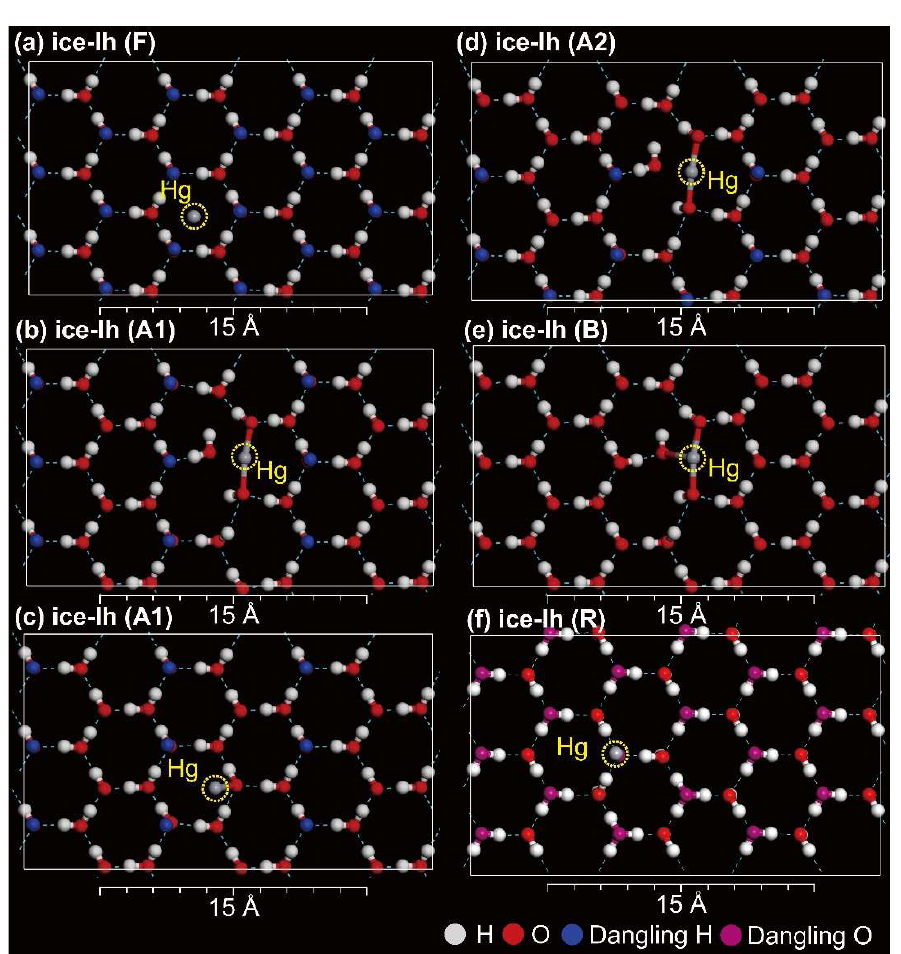
Figure A1. Perpendicular views of the Hg 2+ (yellow dashed circle) adsorbed on different types of ice-Ih surfaces: ( a ) type F site 01, ( b ) type A1 site 01, ( c ) type A1 site 01, ( d ) type A2 site 02, ( e ) type B site 01, and ( f ) type R site 02. Only the atoms in the uppermost layers are depicted.